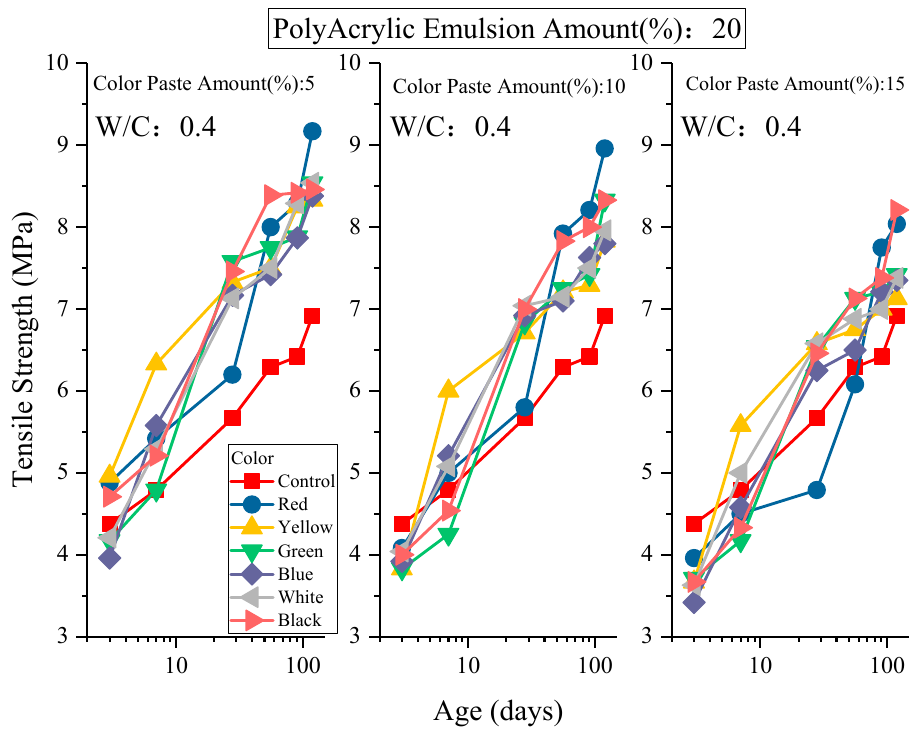
Figure 7. Tensile strength of mortar with different proportions of inorganic color paste.